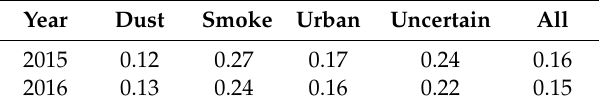
Table4. Thecoe ffi cientsofdeterminationbetweendi ff erenttypesofVisibleInfraredImagingRadiometer Suite Aerosol Optical Depth and PM